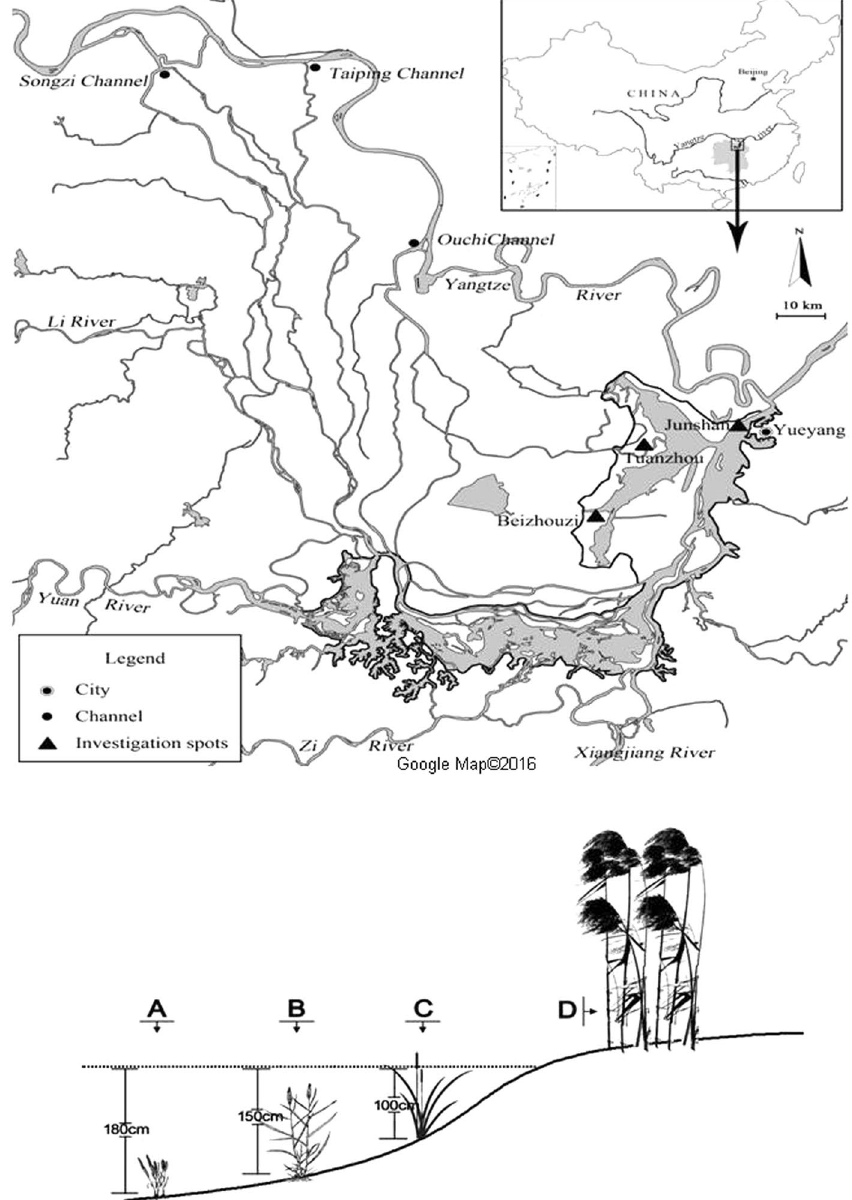
Figure 1. A: Water system and location of sampling sites in Dongting Lake. The shaded areas show the wetlands. B: Distribution patterns of common plants along a water level gradient in Dongting Lake: ( A ) submerged macrophytes, ( B ) Phalaris arundinacea , ( C ) Carex brevicuspis , and ( D ) Miscanthus sacchariflorus (Fig. 1A was generated with software Photoshop